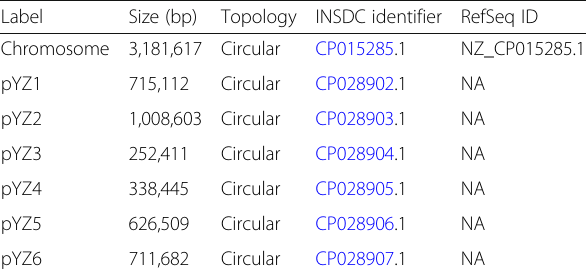
Table 3 Summary of genome: one chromosome and